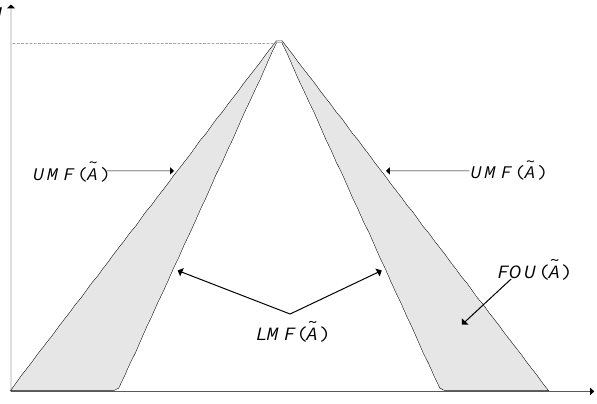
Figure 2. Illustration of interval type-2 (IT2)-membership function (MF). UMF, upper MF; LMF, lower MF; FOU, footprint of uncertainty.